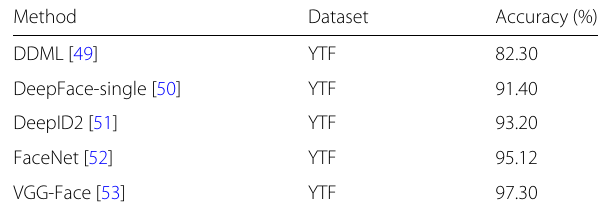
Table 1 Face verification performances of